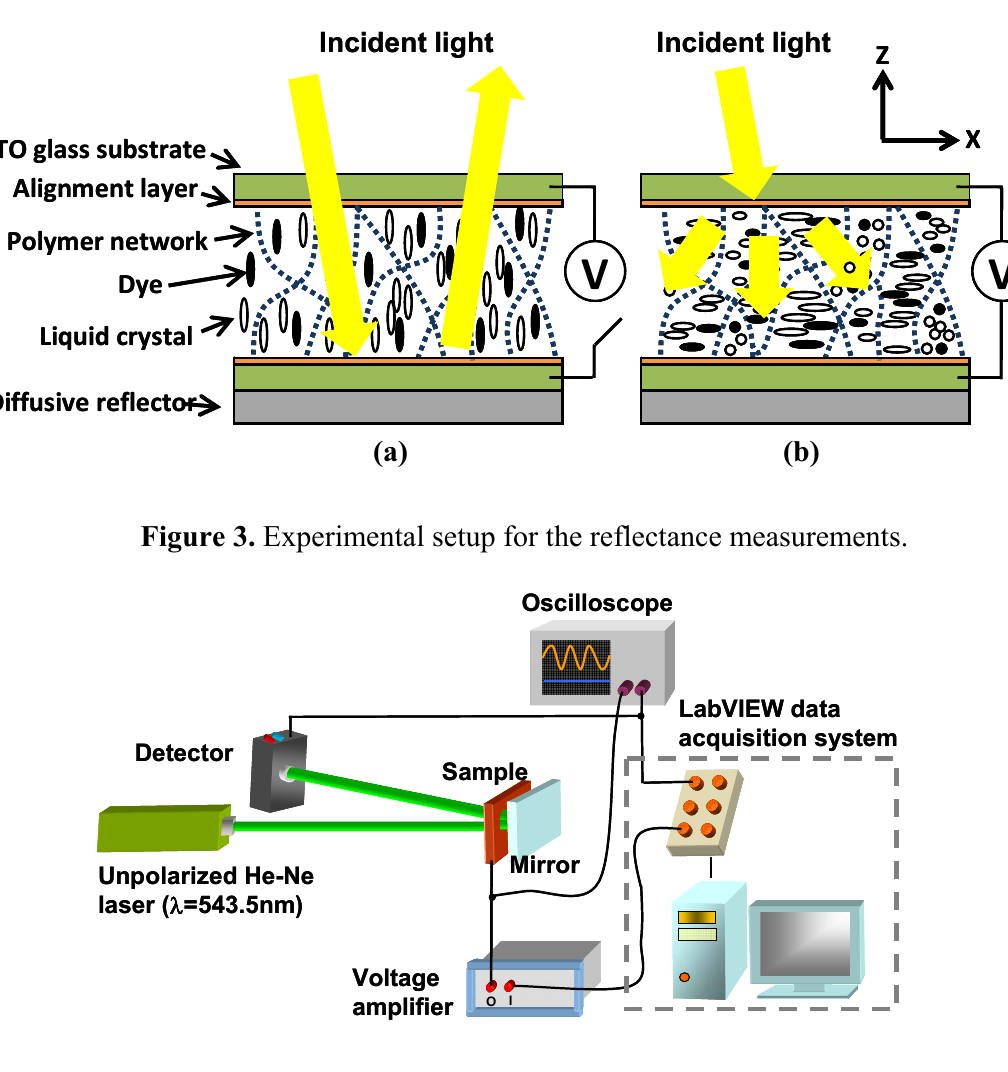
Figure 2. Schematic operating principle of dye-doped gels at (a) voltage-off state and (b) voltage-on state.